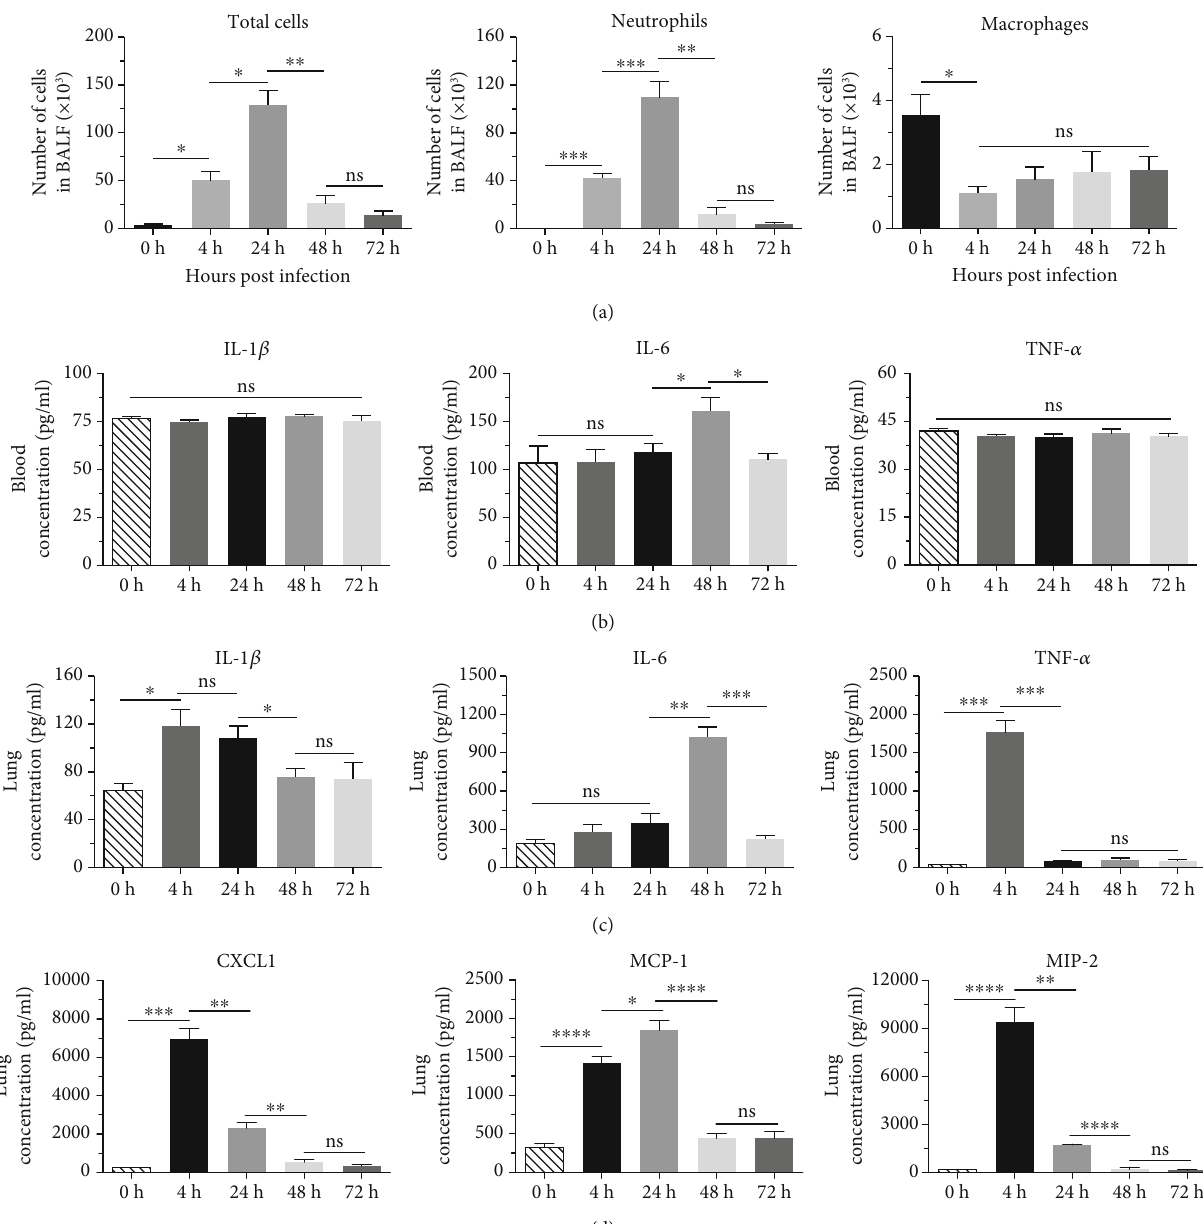
Figure 3: In fl ammatory cell in fi ltration and cytokine/chemokine expression in pneumonia model of K. pneumoniae infection. Mice ( n = 5 ) were infected intratracheally with 5 × 10 4 CFUs of strain YBQ, blood, lungs, and bronchoalveolar lavage fl uid (BALF) samples were collected at 0h, 4h, 24h, 48h, and 72h, respectively. (a) Total cells, macrophages, and neutrophils in BALF samples were quanti fi ed through fl ow cytometry analysis. (b) The levels of IL-1 β , IL-6, and TNF- α in serum and lung samples were detected by ELISA. (c) The levels of MCP-1, MIP-2, and CXCL-1 in lung samples were quanti fi ed by ELISA. These assays were performed in triplicate, and representative data from one experiment were expressed as means ± SEM . Statistical analyses were performed by Student ’ s t test. P < 0 : 05 ( ∗ ), P < 0 : 01 ( ∗∗ ), P < 0 : 001 ( ∗∗∗ ), and P < 0 : 0001 ( ∗∗∗∗ ) compared to each